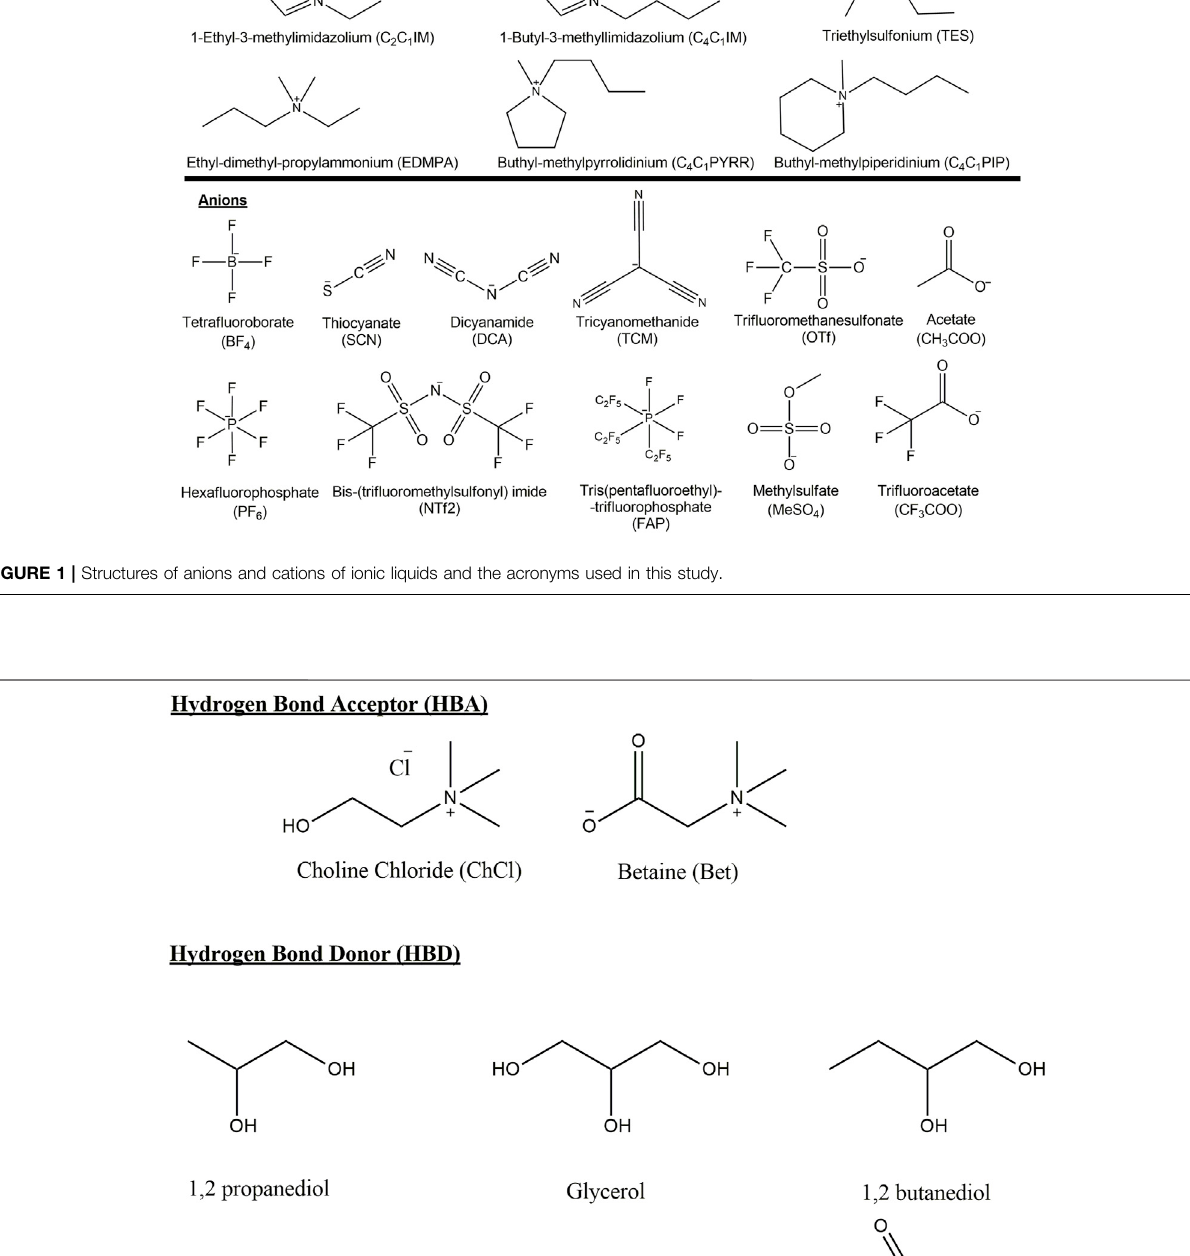
Frontiers in Chemistry |